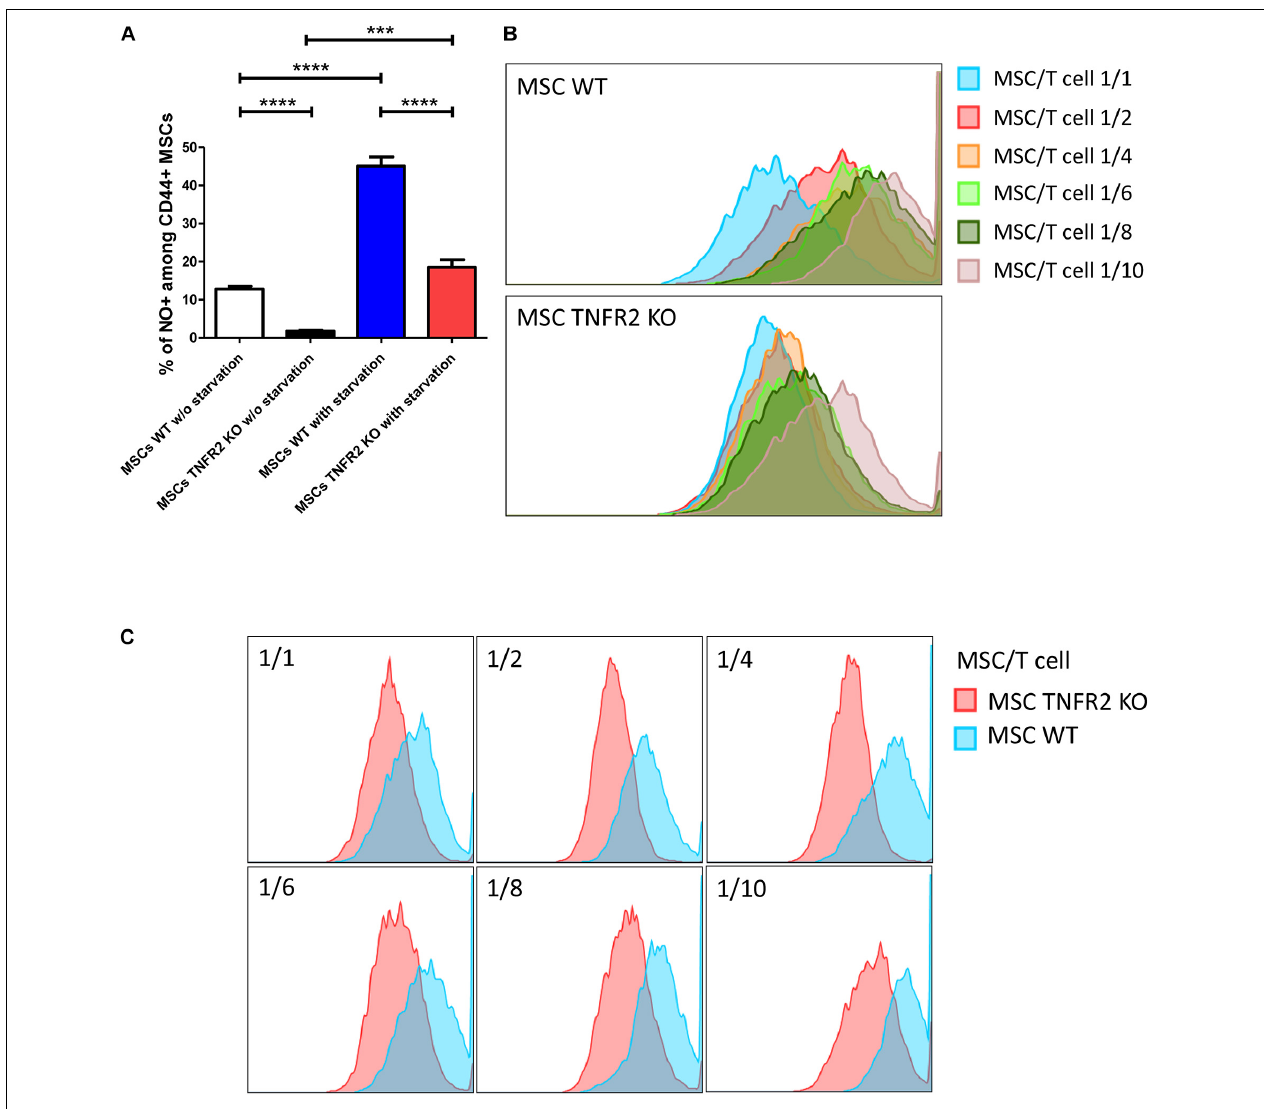
FIGURE 4 | The expression of TNFR2 by mesenchymal stem cells (MSCs) is correlated to their higher NO production. NO production was evaluated by flow cytometric measurement. (A) Percentages of NO producing MSCs were identified at basal level without starvation (P2 and P3) and when cultured in medium containing 0.5% fetal bovine serum (FBS) creating cellular stress (P2 and P3). The first two bars represents the wild-type (WT) and TNFR2 knockout (KO)-MSCs cultured without starvation ( n = 9), while the third and fourth bars are WT and TNFR2 KO-MSCs, respectively, cultured in starvation condition ( n = 9). (B) To assess MSCs’ reaction in the presence of T cells, we have created an inflammatory condition by co-culturing both MSCs (P2 and P3) with six increasing ratios of activated T cells (1/1 up to 1/10 MSC/T cell ratio). (C) Comparing MSCs in each T cell dose revealed that the blockade of TNFR2 resulted in less NO production in every single ratio. Results are collected from three independent